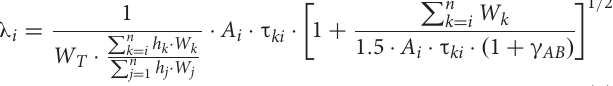
is necessary to determine the collapse multiplier λ i in X and Y directions. For this purpose, the expression provided by Benedetti and Petrini (1984) and reported in Eq. (3) is used.